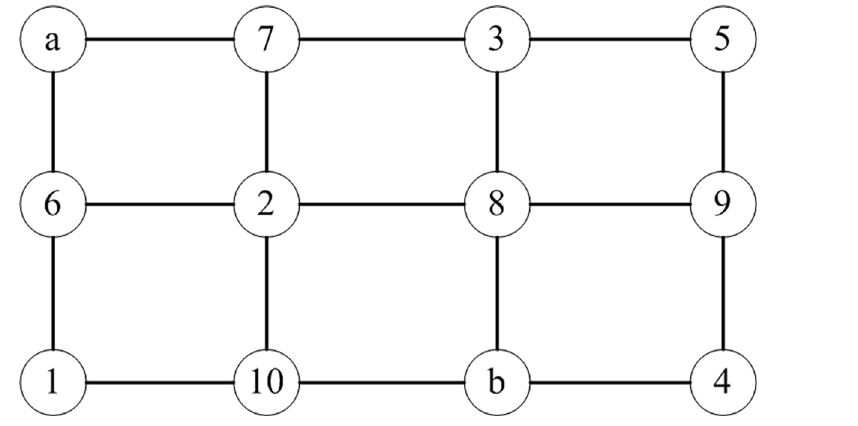
Fig 2. Diagram of the transportation